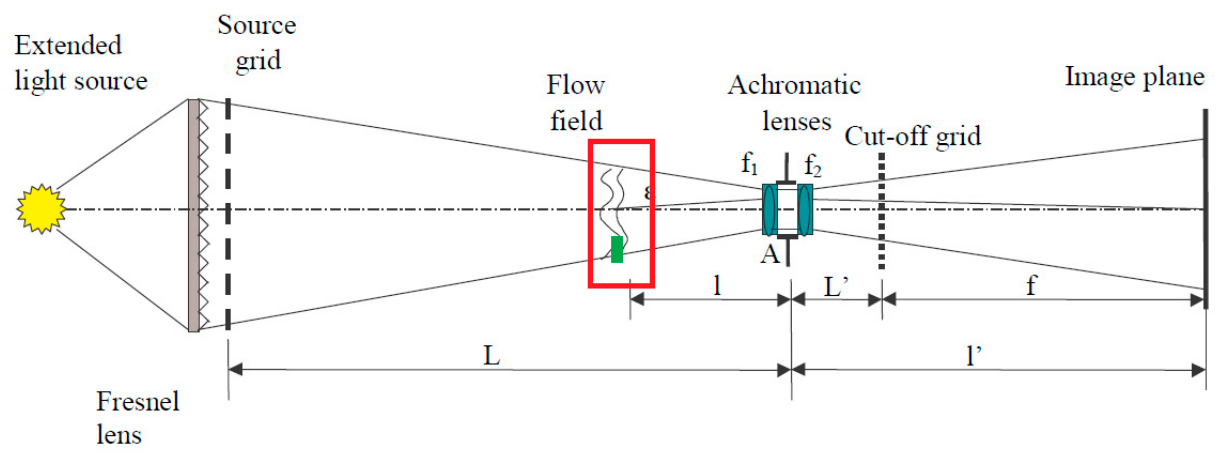
Figure 20. Focusing Schlieren technique layout. Reprinted with permission from Ref. [42] (2011).